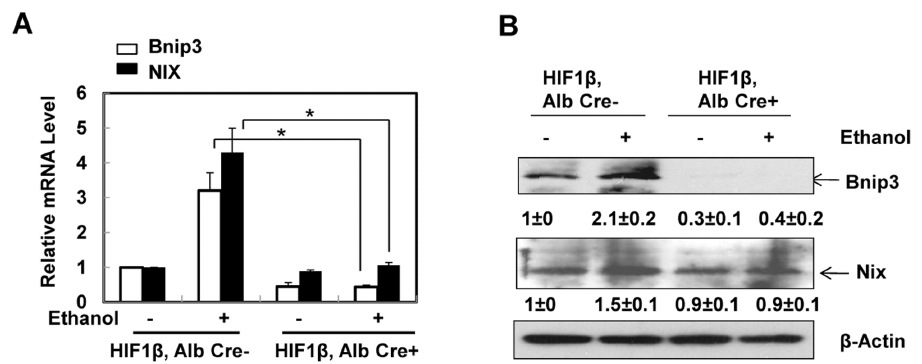
Fig. 2. Ethanol-induced expression of BNIP3 and NIX was abolished in primary cultured HIF-1 b knockout mouse hepatocytes. ( A ) Primary cultured wild type and HIF-1 b knockout hepatocytes were treated with ethanol (80 mM) for 6 hours. mRNA was isolated from cultured hepatocytes and real-time RT- PCR was performed as described in the Materials and Methods. Data are presented as means ¡ SE (n 5 4). * p , 0.05. One way ANOVA with Scheffe´’s post hoc test. ( B ) Cells were treated as in ( A ), total cell lysates were subjected to western blot analysis. Densitometry was performed and data are presented as a ratio vs HIF-1 b , Alb Cre- control (n 5